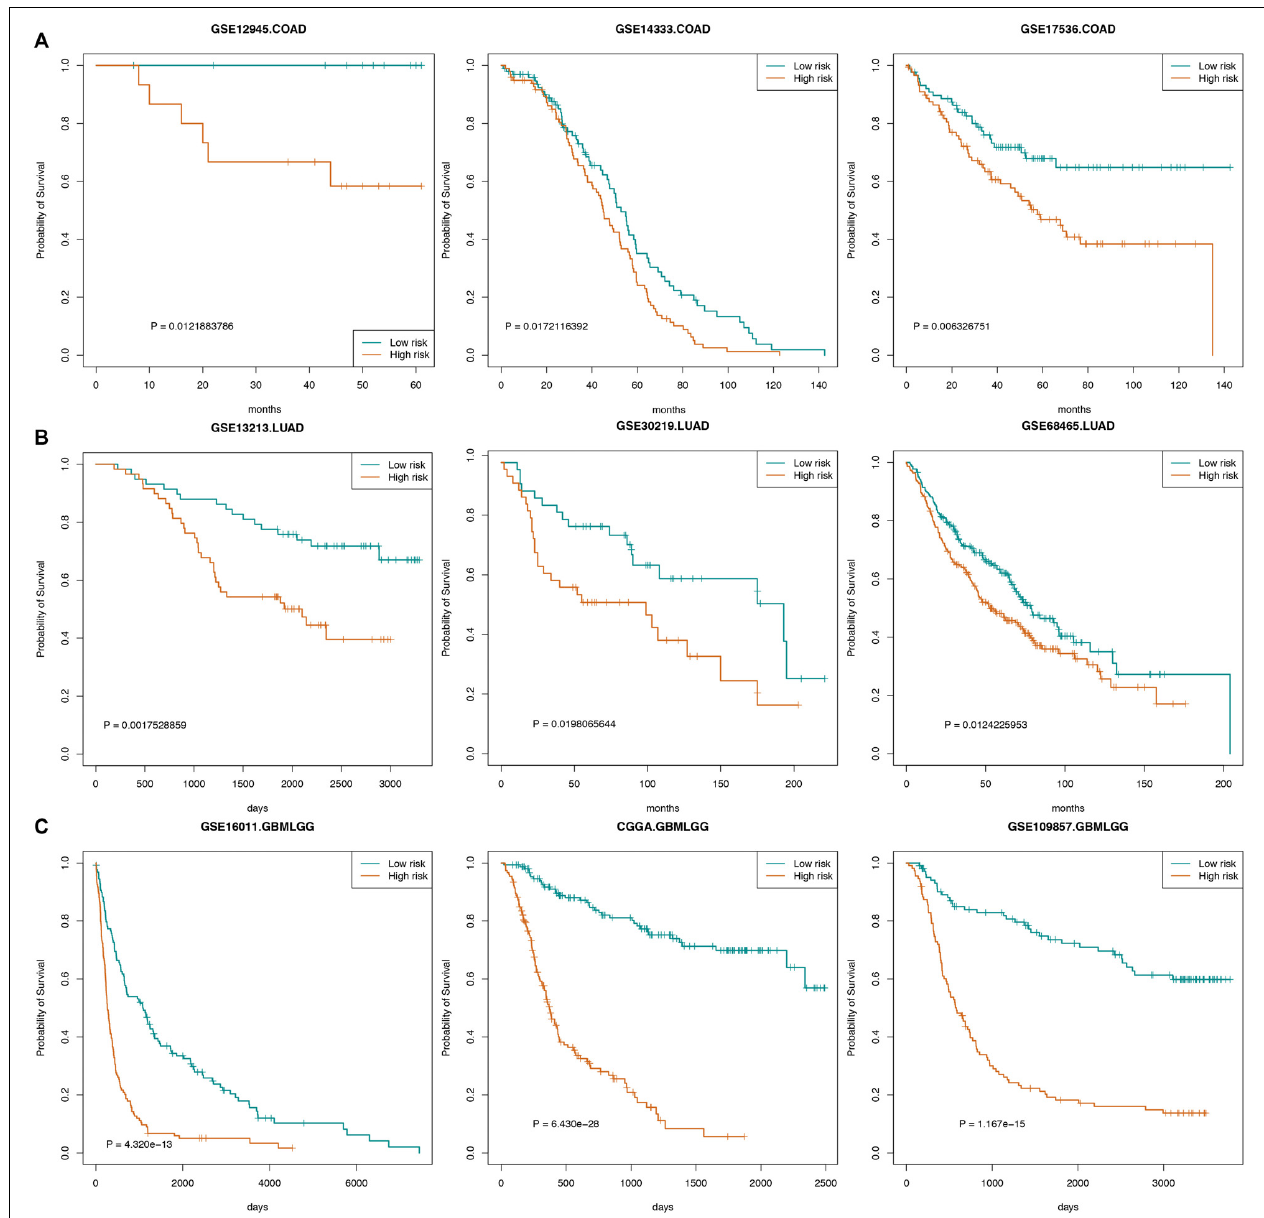
FIGURE 5 | Survival curves for cancers. (A) The survival curve of COAD patients in GSE14333, GSE12945, and GSE17536. (B) The survival curve of LUAD patients in GSE30219, GSE13213, and GSE68465. (C) The survival curve of GBMLGG patients in GSE109857, GSE16011, and